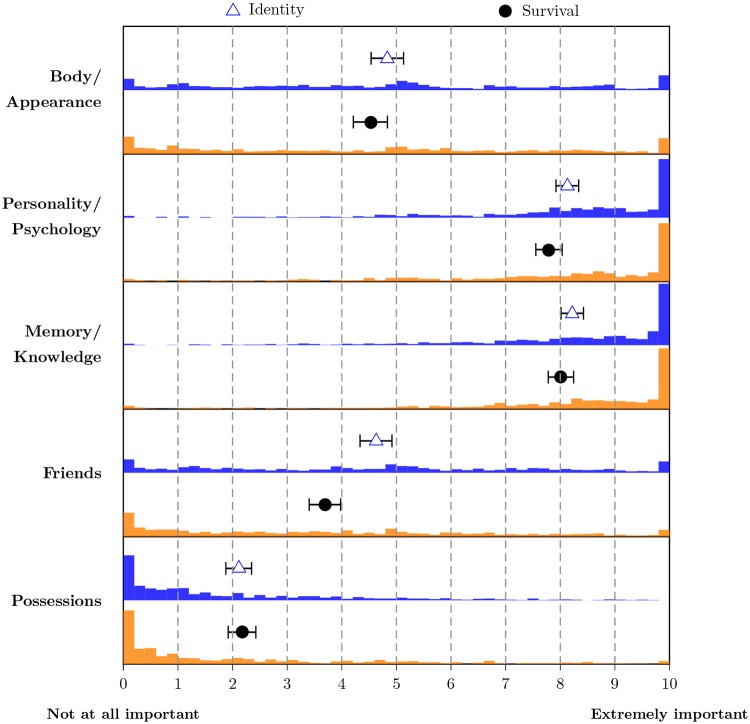
Importance assigned to the five dimensions for identity and survival (N = 704).Triangles denote the means and blue bars show the histogram for answers to the five identity questions; dots and orange bars show the corresponding information for the survival questions. Whiskers signify the 99% confidence intervals for the means.